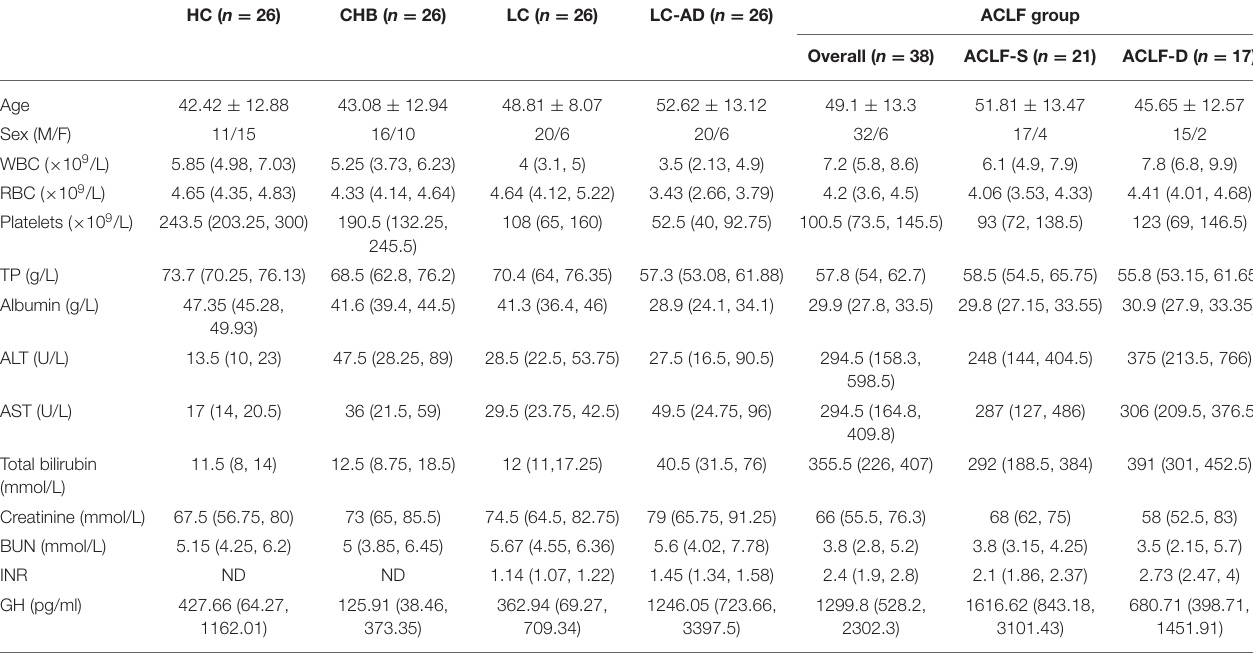
TABLE 2 | Characteristics of the cross-sectional cohort.